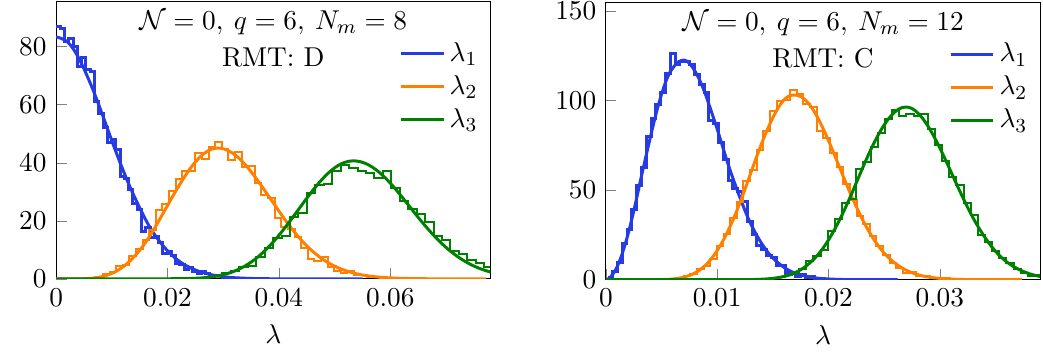
Figure 2 . Distributions of the eigenvalues of H with smallest absolute values in the N = 0 SYK model with q = 6 and J = 1, compared with the predictions (solid lines) of the RMT classes in table 3. The number of independent random samples is 10 4 for each plot. The small deviations from RMT for the third nonzero eigenvalue are interpreted to be e(cid:11)ects of (cid:12)nite N m